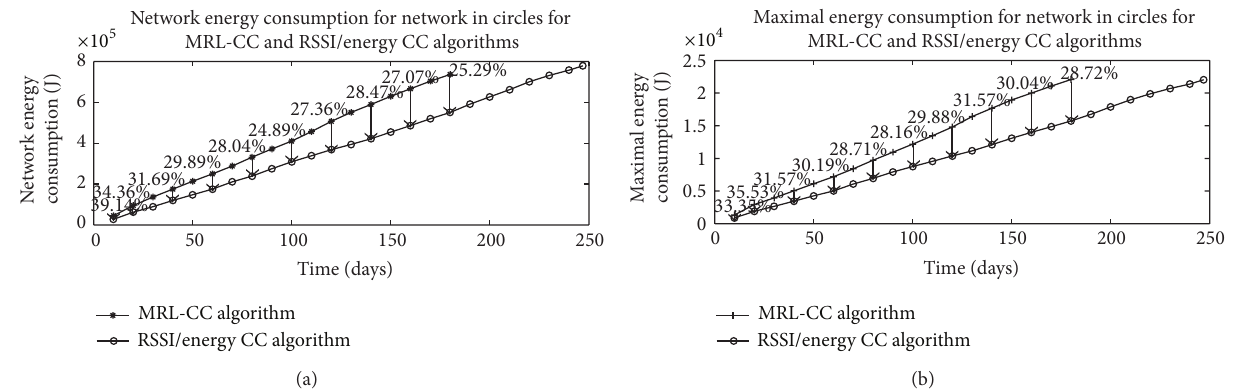
Figure 13: Network energy consumption and maximal energy consumption for network in form of circles, for MRL-CC algorithm and RSSI/energy CC algorithm.